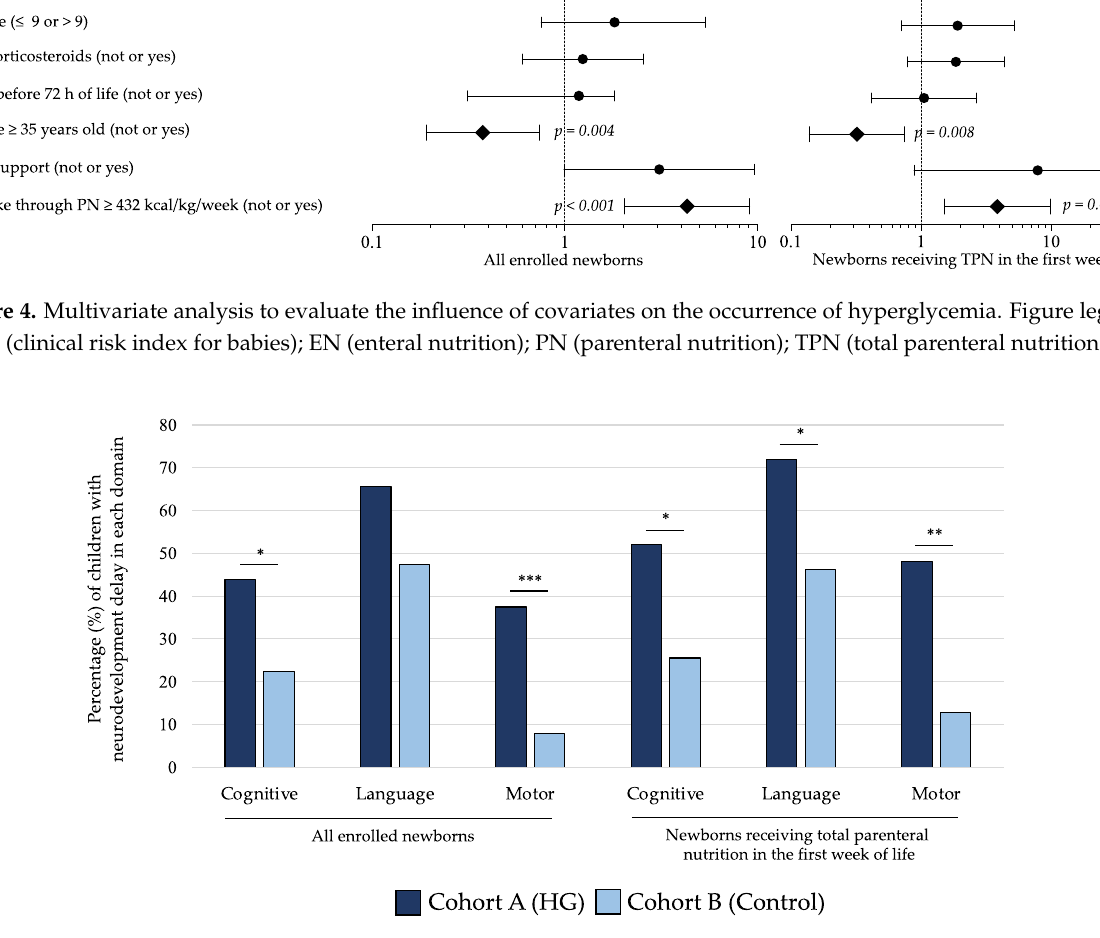
Figure 5. Percentage of children with neurodevelopment delay in each domain of Bayley Scale of Infant Development at 24 months of life of the two study cohorts. Figure legend: HG (hyperglycemia); * p -value < 0.05; ** p -value < 0.01; *** p -value < 0.001. Table 3. Neurodevelopmental outcome at 24 months of life of the study population. Overall In TPN in the First Week of Life